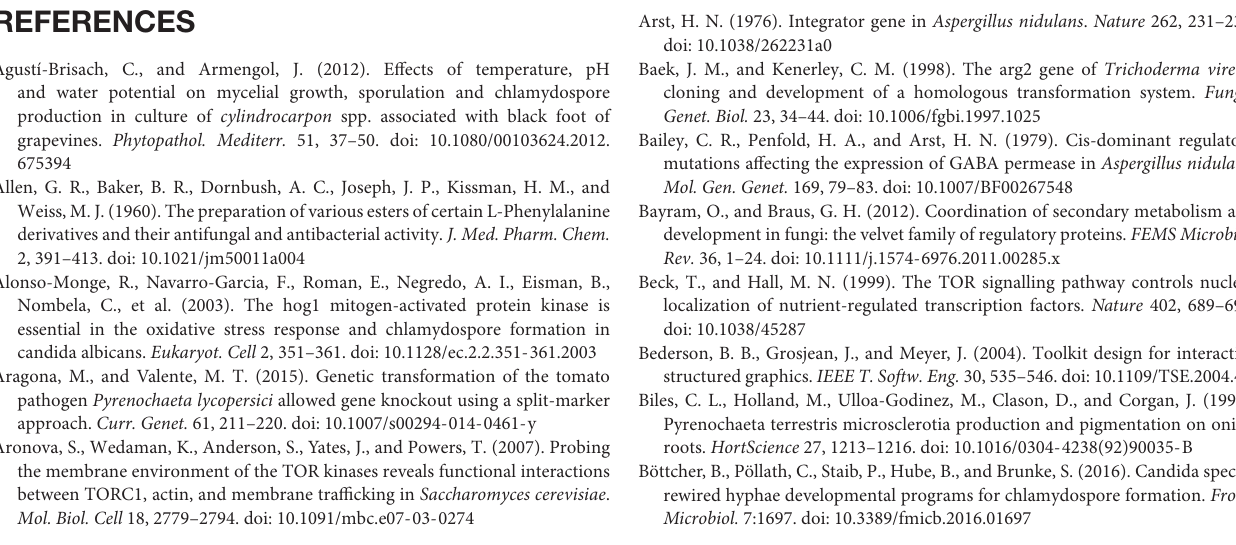
Supplementary Figure 10 | Fatty acid metabolic pathway(fatty acid degradation(tre00071), biosynthesis of unsaturated fatty acid (tre01040) and fatty acid biosynthesis pathway (tre00061)). The green box represents a specific gene or enzyme in Trichoderma Reesei and does not indicate up-regulation or down-regulation of the gene. Supplementary Figure 11 | Starch and sucrose metabolism pathway (tre00500). DEGs in starch and sucrose metabolism pathway: 3.2.1.39: glucan endo-1,3-beta-D-glucosidase (25786810); 3.2.1.21: beta-glucosidase (25797680); 3.2.1.28: alpha,alpha-trehalase (25794082); 5.4.2.2: phosphoglucomutase (25798750). The green box represents a specific gene or enzyme in Trichoderma Reesei and does not indicate up-regulation or down-regulation of the gene. Supplementary Figure 12 | Amino sugar and nucleotide sugar metabolism (tre00520). DEGs in Amino sugar and nucleotide sugar metabolism pathway: 3.2.1.14: chitinase (25795194/25786774/25786843); 3.2.1.52: beta-N-acetylhexosaminidase (25786802); 5.4.2.3: phosphoacetylglucosamine mutase (25787876); 3.2.1.165: exo-1,4-beta-D-glucosaminidase (25794739); 2.4.1.16: chitin synthase (25798917/25797926/25797171);